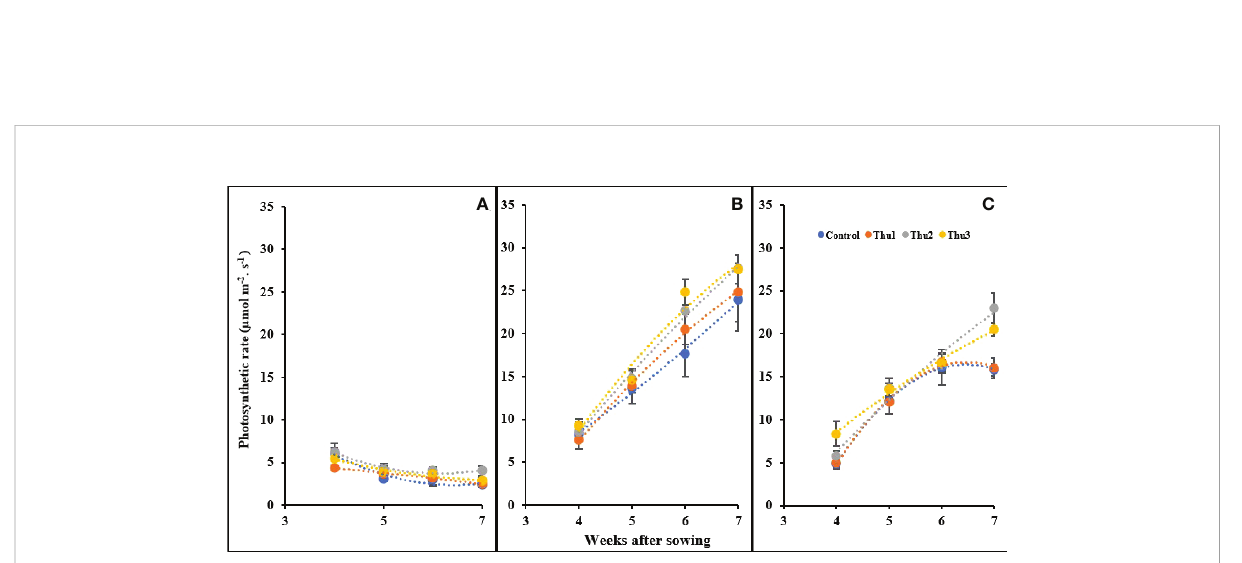
FIGURE 12 Changes in the photosynthetic rate under application of Th17 at low (A) , optimum (B) and high (C) temperature at 4, 5, 6 and 7 weeks after sowing. Thu1: 10 -7 M Th17, Thu2: 10 -9 M Th17, Thu3: 10 -11 M Th17. Each point represents mean ± standard error